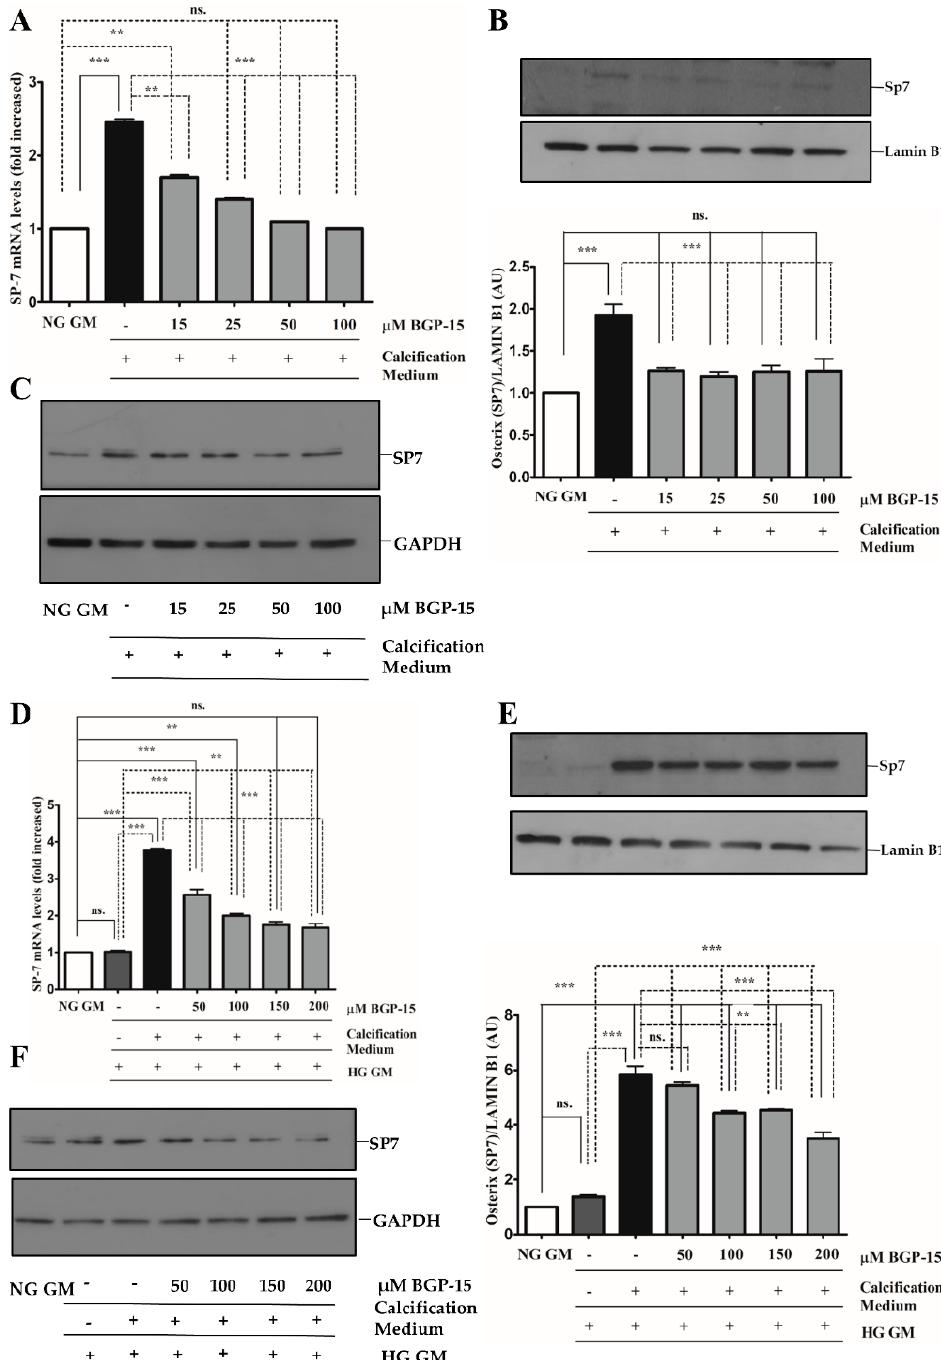
Figure 9. BGP-15 decreases Sp7 expression and nuclear translocation induced by high Pi in NG and HG conditions. VSMCs were treated as in Figure 2. Expression of Sp7 were analyzed by RT-qPCR and immunoblot ( A – D ). Expression of Sp7 was analyzed by RT-qPCR and immunoblot ( A – F ). Relative expression of Sp7 mRNA ( A ) and protein ( B , C ) in NG condition (( B ): Protein from nuclear extracts normalized to Lamin B1; ( C ): Cytosolic fractions normalized to GAPDH). Relative expression of Sp7 mRNA ( D ) and protein ( E , F ) in HG condition (( E ): Protein from nuclear extracts normalized to Lamin B1; ( F ): Cytosolic fractions normalized to GAPDH). Data are presented as mean ± SEM of three independent experiments. Relative mRNA expression was normalized to RNA45S. Statistical analysis was performed by the one-way ANOVA test followed by Bonferroni correction. A value of p < 0.05 was considered significant. ** p < 0.01, *** p < 0.001.